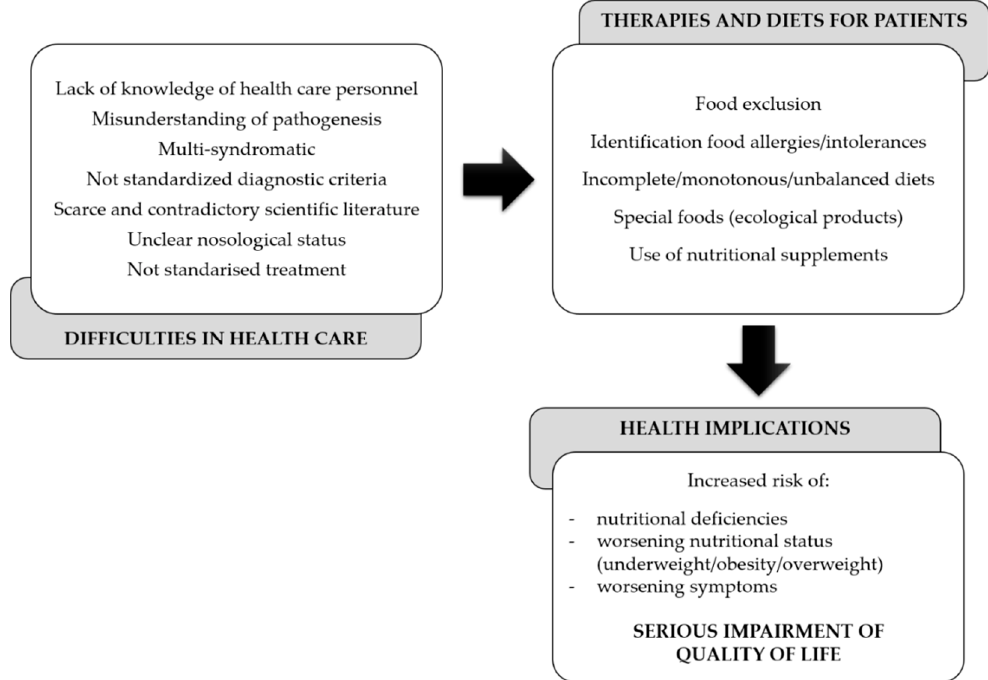
Figure 1. Gaps in the dietary and nutritional management of central sensitization syndromes (CSSs).